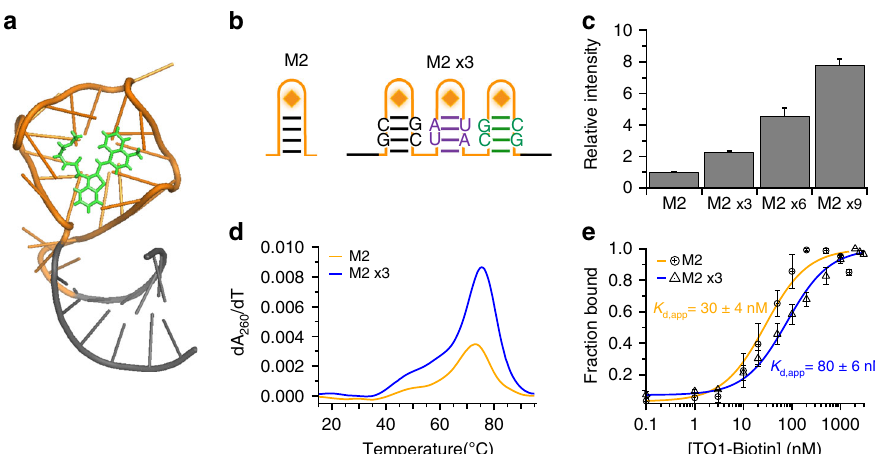
Fig. 1 In vitro characterisation of tandem Mango II arrays. a Crystal structure of Mango II aptamer (G-quadruplex — orange, Stem — grey) with TO1-Biotin bound (green). Taken from 29 PDB ID: 6C63. b Diagram of Mango II and the Mango II x3 array with mutated bases purple and green. c Fluorescence increase of short Mango array constructs (40nM) upon addition of an excess of TO1-Biotin (1 µ M), error bars depict the standard deviation. d Differentials of the UV melting curves for each Mango array. e Titration of TO1-Biotin for each Mango construct, with a Hill equation fi t to determine K d,app . Mango II — orange lines and black circles, Mango II x3 — blue lines and black